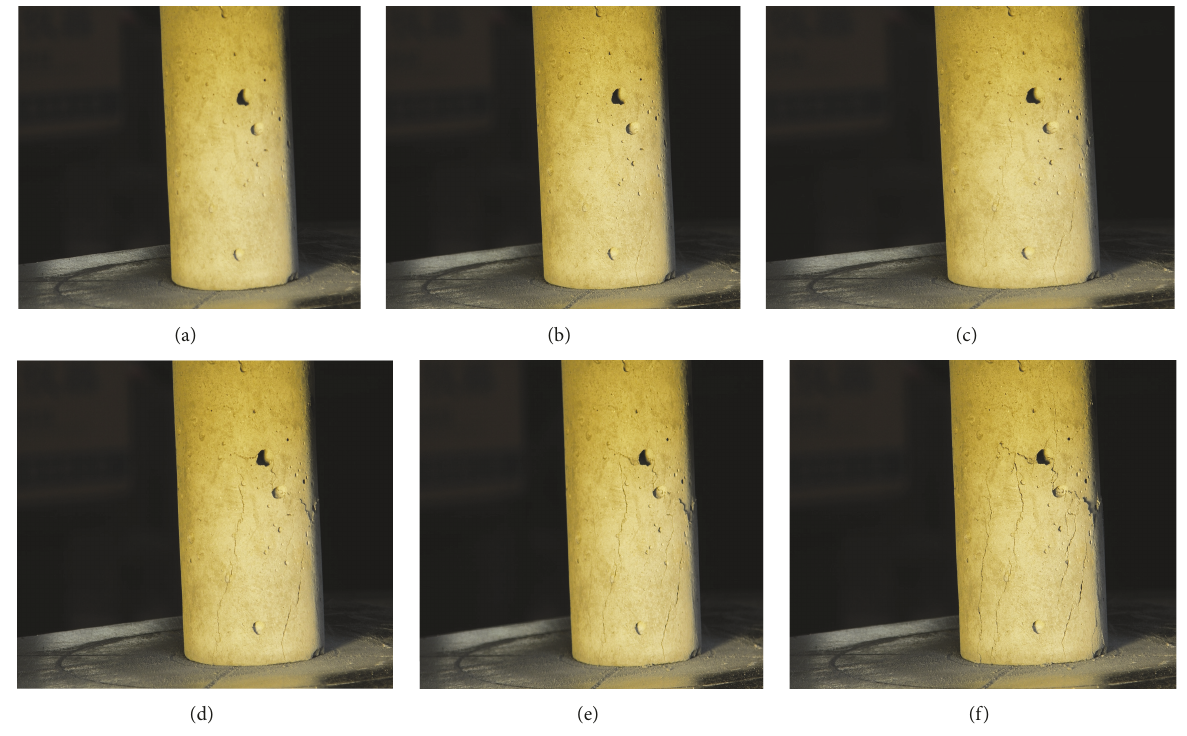
Figure 4: Fracture changes in the process of specimen compression.